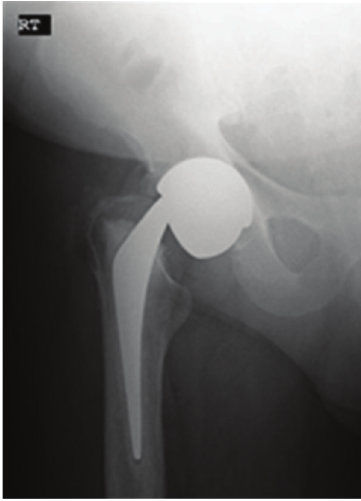
Figure 1: Anteroposterior radiograph demonstrating the fracture of the C-stem at the head-neck